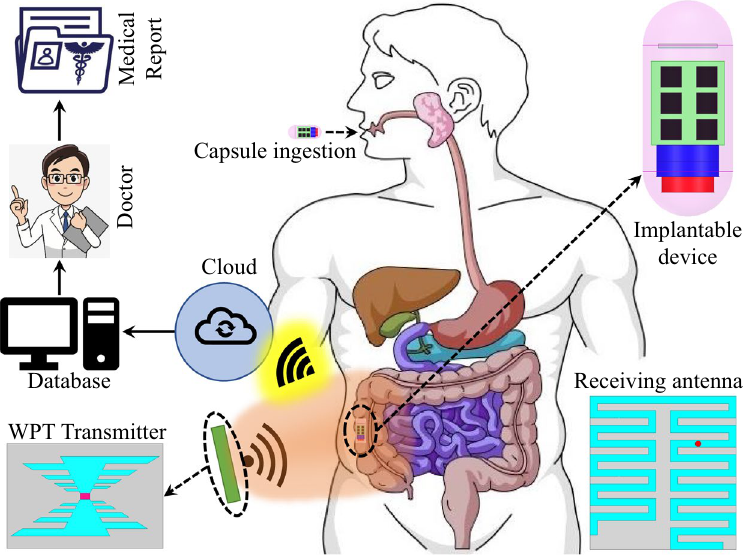
Figure 1. Generalized wireless power transfer (WPT) system for deep-implanted biomedical